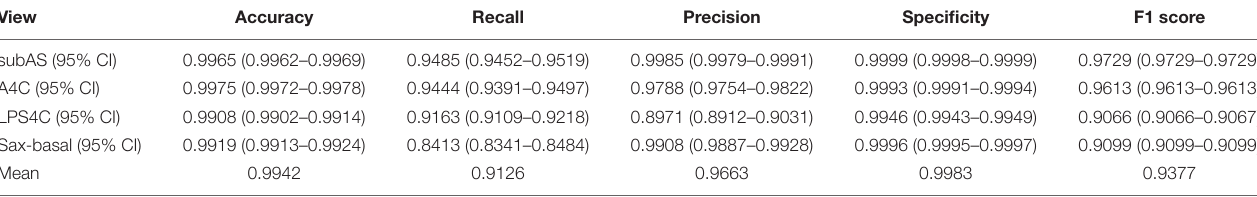
TABLE 3 | Performance results of standard view identification.